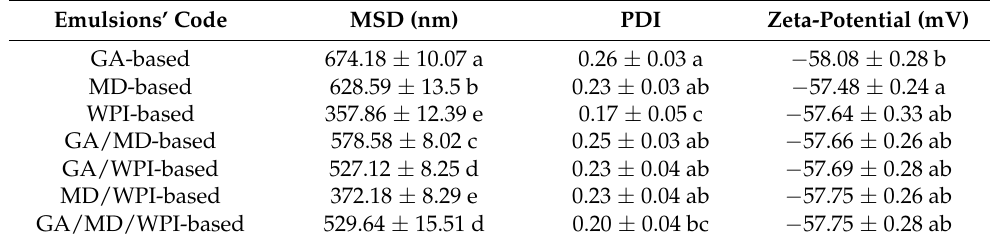
Table 2. MSD, PDI, and ζ -potential of fresh